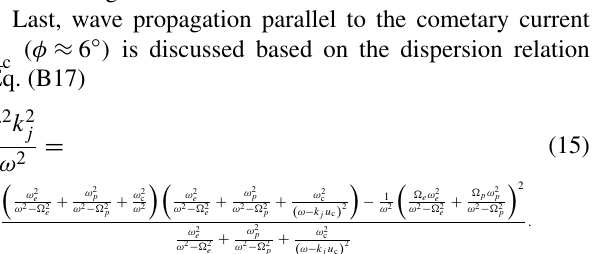
Figure 5. Left: estimated growth rate γ c range in the plane perpendicular to the cometary current j between the estimated lower limit of k max = 6 . 4 × 10 − 3 km − 1 and the asymptotic upper limit of the growth rate. Since in this plane no real frequency is given in SW, only the growth rate is shown. Right: comparison between the frequencies with maximum growth rate of ω c in SW (red) and CSEQ (blue) with variation of the azimuth φ in the plane perpendicular to the ambient magnetic field B 0 . In addition, the corresponding maxima of the growth rate (black) are shown. For propagation k ⊥ j due to the missing maximum. Additionally, characteristic propagation directions are marked in both